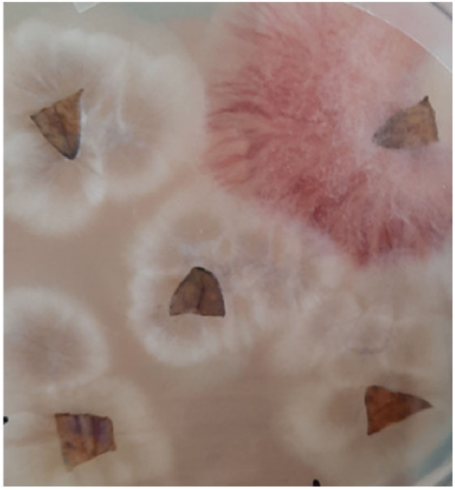
Figure 3. Fungal ( B. bassana and F. oxysporum f. sp. lycopersici) outgrowths from leaf